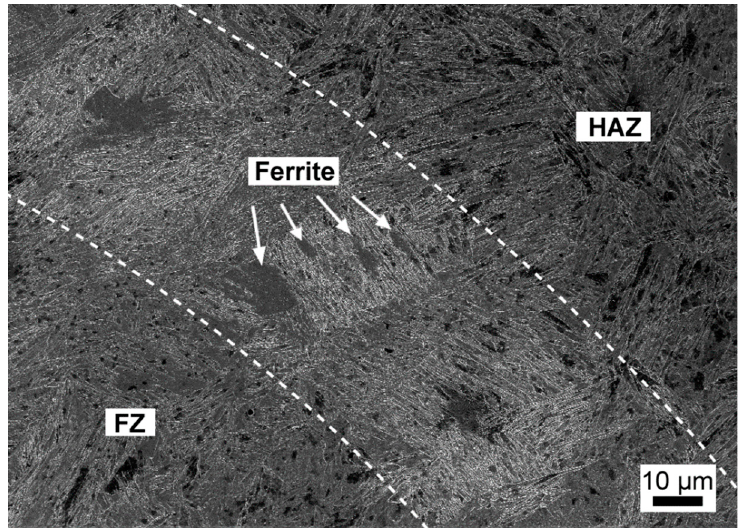
Figure 13. An overview of the PMZ under SEM.